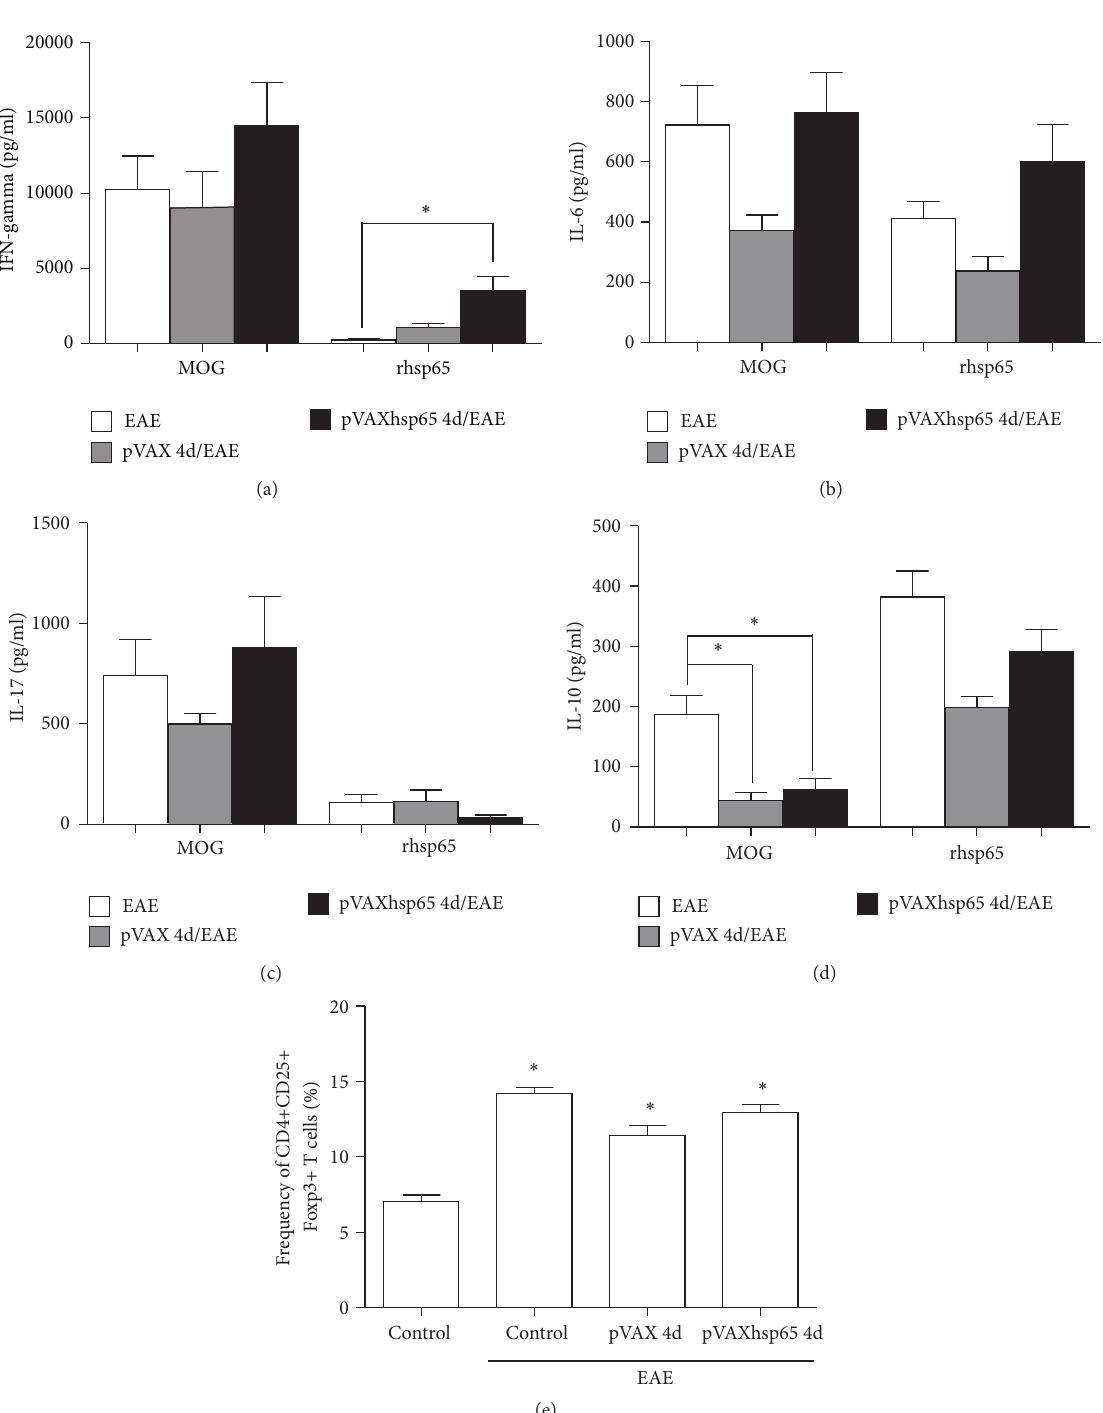
Figure 4: Effect of previous vaccination with pVAXhsp65 on peripheral immune response . C57BL/6 mice were immunized with 4 pVAXhsp65 doses and then submitted to EAE induction. Cytokine production was assessed 30 days after EAE induction. IFN- 𝛾 (a), IL-6 (b), IL- 17 (c), and IL-10 (d) production were assayed in spleen cell cultures restimulated in vitro with MOG 35 CD4+CD25+Foxp3+ T cells was evaluated in the total number of spleen cells 30 days after EAE induction (e). Data were presented by mean ± SE of 6 mice and are representative of two independent experiments. ∗ represents the difference between DNA injected groups and control group with EAE. 𝑝 < 0.05